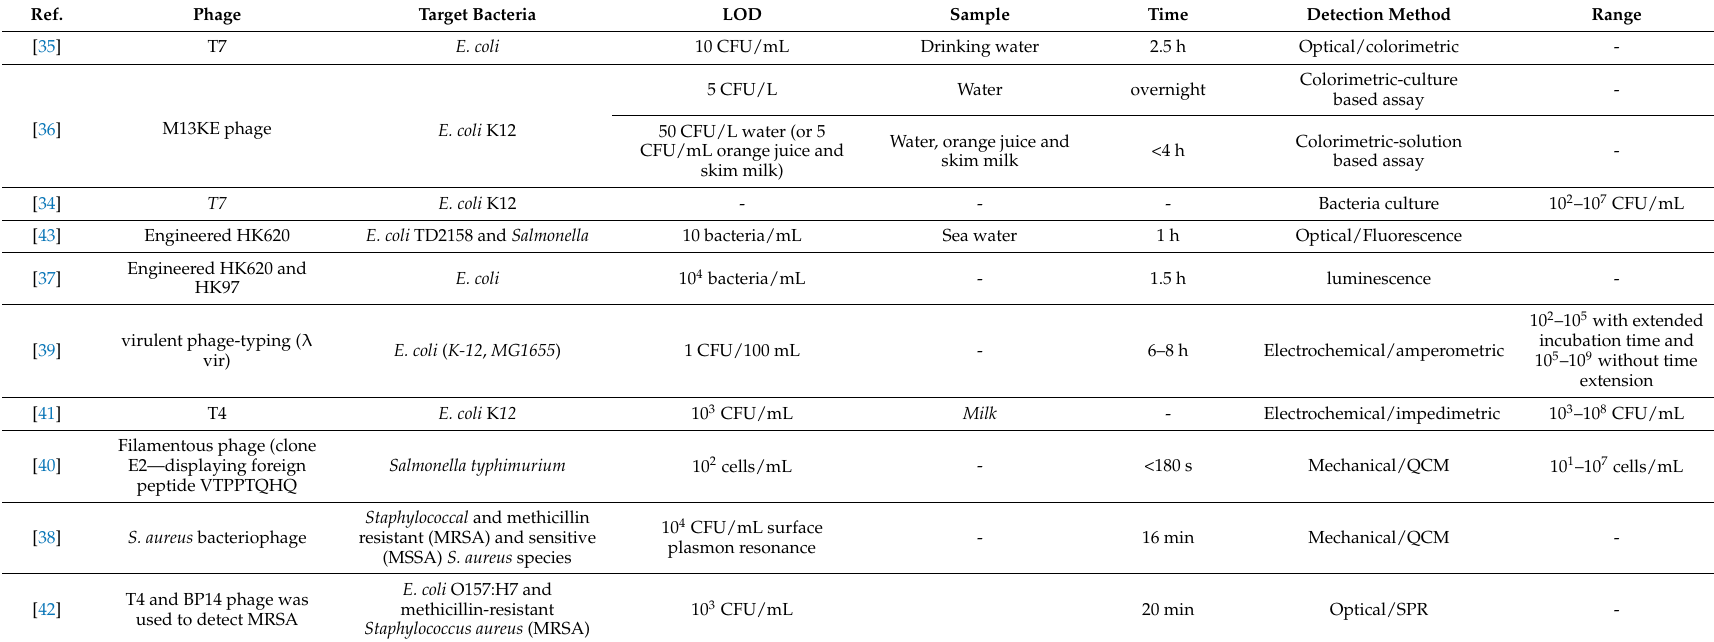
Table 3. Phage-based biosensors for bacteria